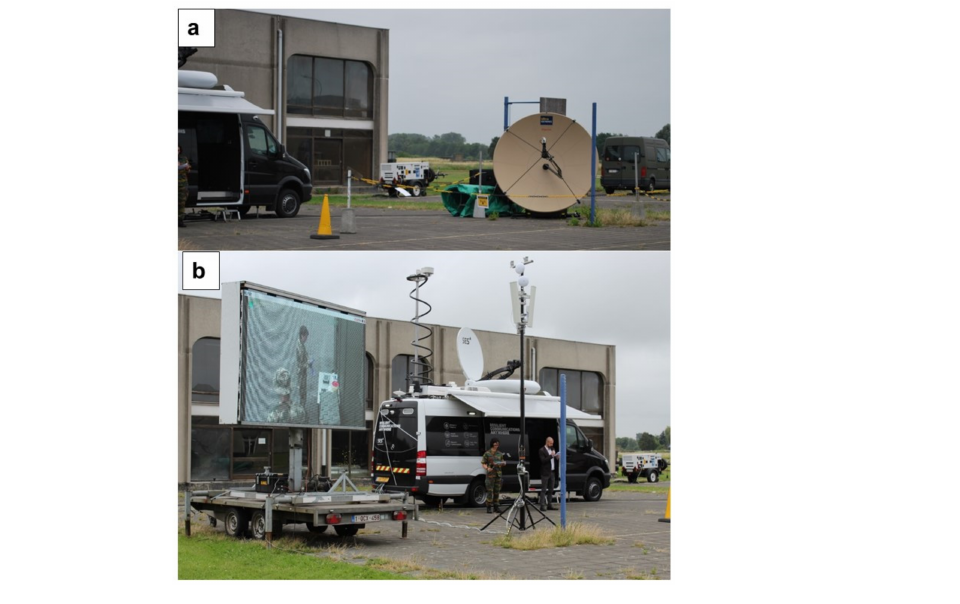
Figure 8. Bio-Garden Exercise: ( a ) Gigasat deployable antenna and antenna mast#2 with WiFi equipment; ( b ) SES rapid response vehicle.